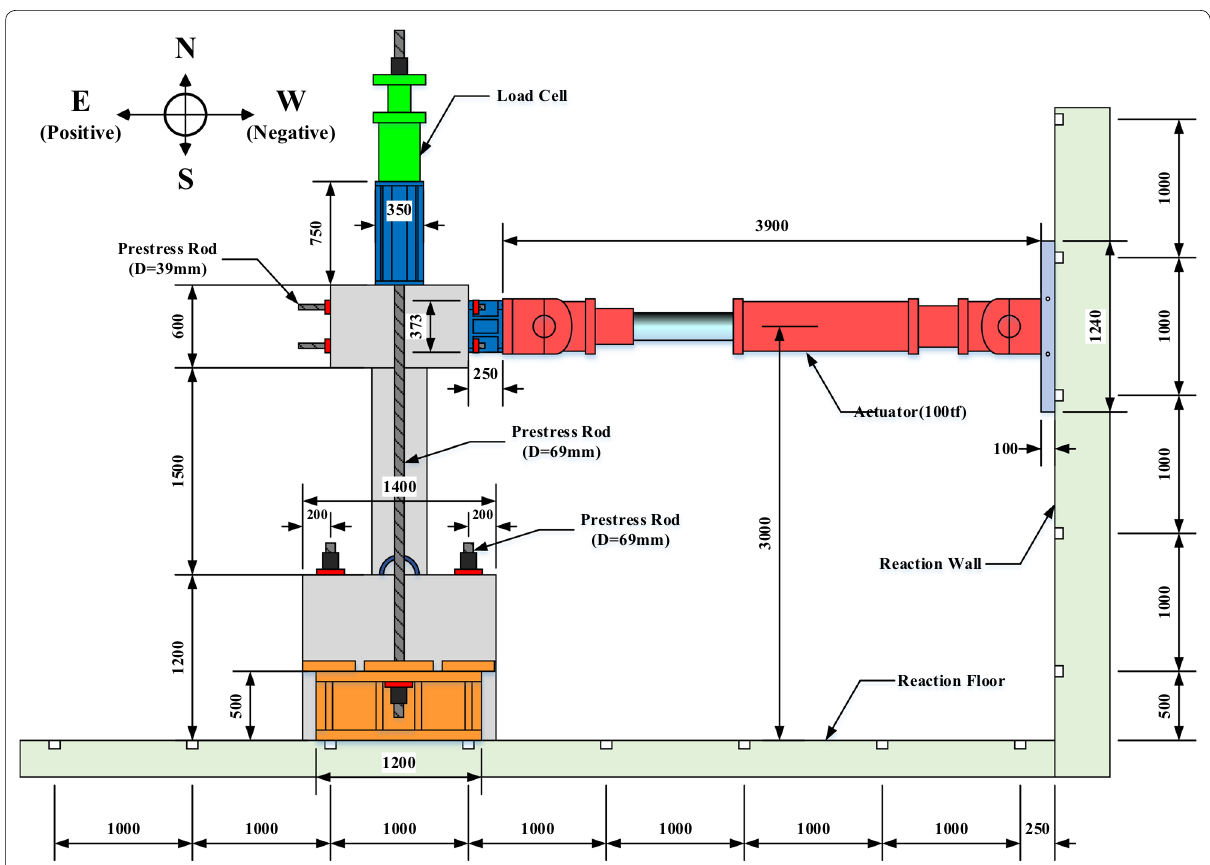
Fig. 4 Applied loading system for the cantilever beam specimens in this